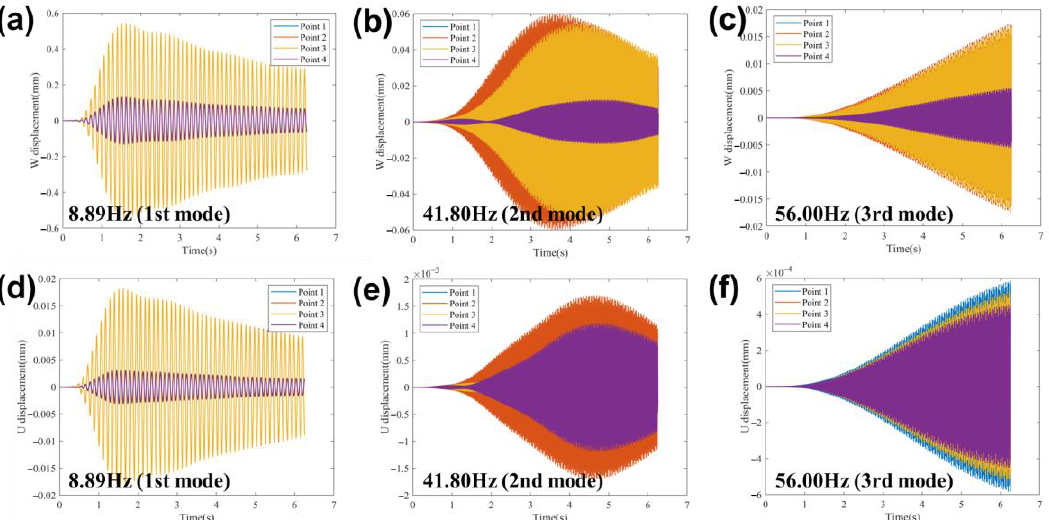
Figure 11. The out-of-plane displacements extracted at the natural frequencies of ( a ) 8.89 Hz, ( b ) 41.80 Hz, ( c ) 56.00 Hz and the in-plane displacements extracted at the natural frequencies of ( d ) 8.89 Hz, ( e ) 41.80 Hz, ( f ) 56.00 Hz.